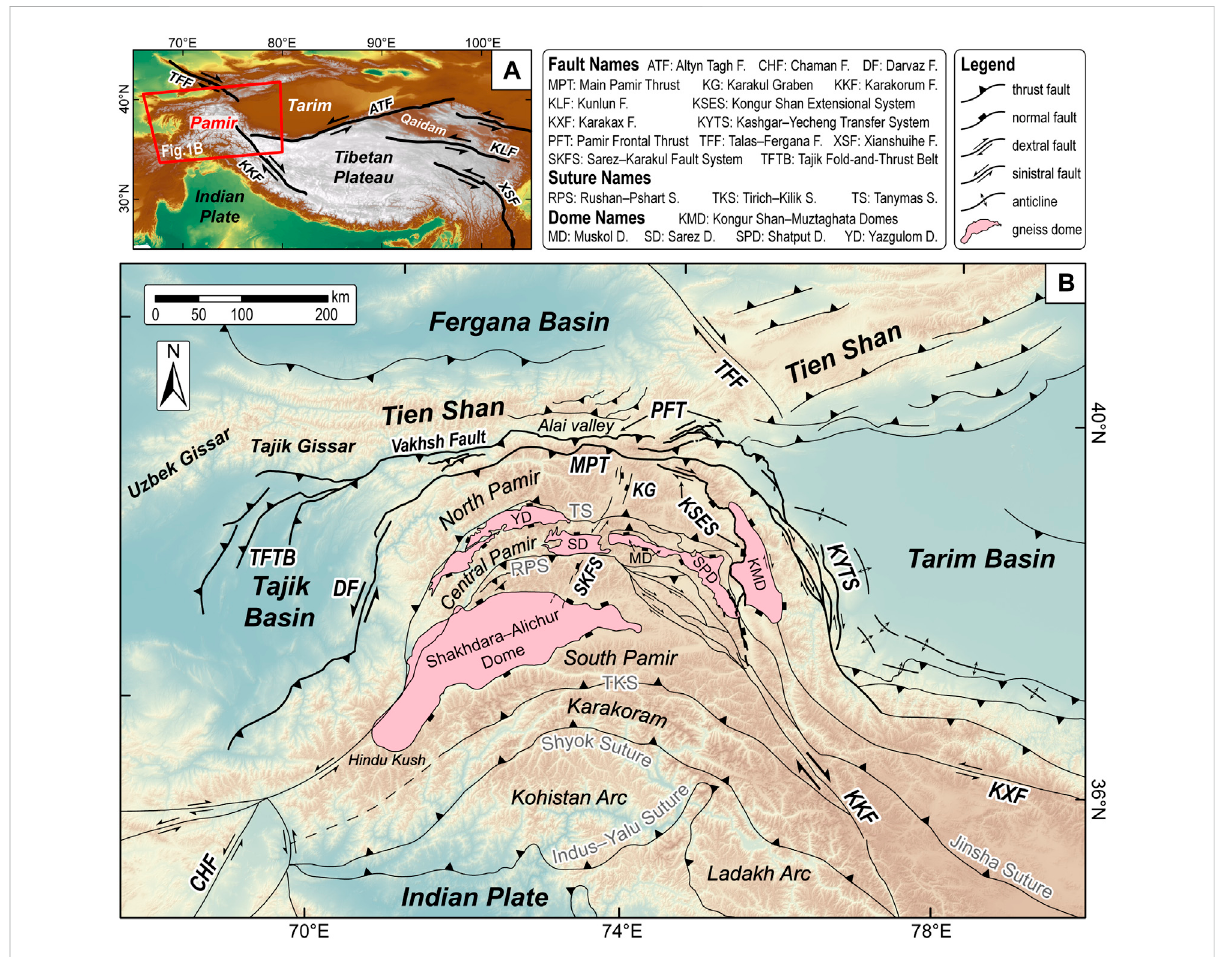
FIGURE 1 Tectonic setting of the study area and its surrounding regions. (A) The location of the Pamir salient within the tectonic context of the Himalayan – Tibetan orogen. (B) Tectonic map of the Pamir salientand its adjacent areas (modi fi edfrom Weietal. (2018) after Robinson etal. (2004), Robinson et al. (2007), Cowgill (2010), and Stübner et al. (2013a)). The bold black lines denote the arc-like active structures along the frontal Pamir salient. The pink- fi lled polygons de fi ne the Cenozoic gneiss